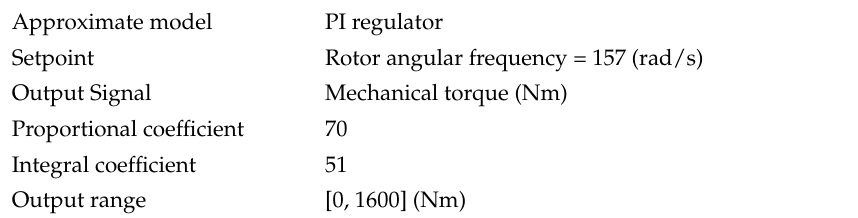
Table 5. Parameters of the governing system for the SG.